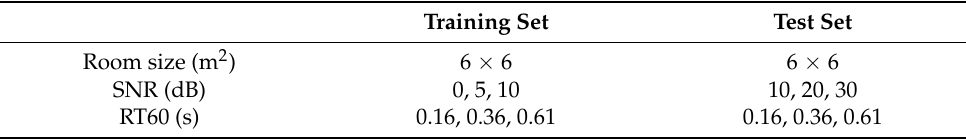
Table 8. The real acoustic environment configuration.